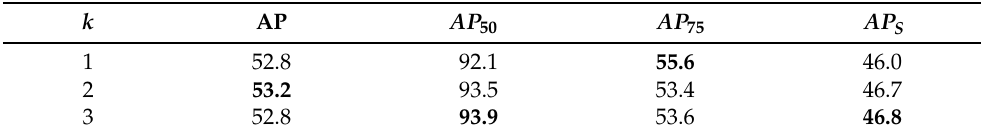
Table 7. Detection results on SSDD when k takes different values.